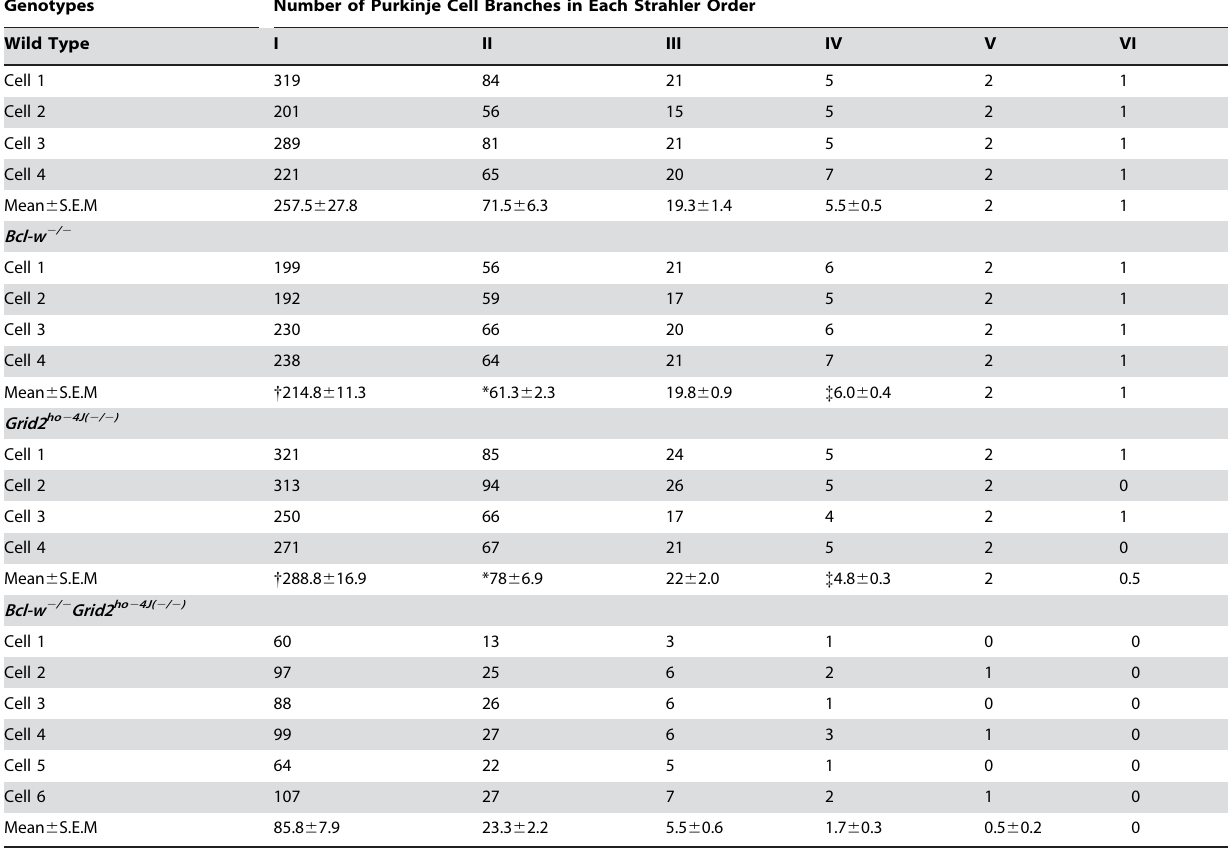
Purkinje cell dendritic abnormalities in Bcl-w 2 / 2 Grid2 ho 2 4J( 2 / 2 ) mice were quantified using the Strahler system of topological analysis on Golgi-stained Purkinje cells. The number of the dendritic branches in each Strahler order was counted for several Purkinje cells for wild type, single knockout, and double knockout mice. Statistic analysis was performed between two genotypes of mice in each order using student t-test. Purkinje cells in Bcl-w 2 / 2 Grid2 ho 2 4J( 2 / 2 ) mice are significantly different from all other genotypes in every Strahler order (p , 0.01). { , * , { Indicate the significant difference (p , 0.05) in the first, the second, and the fourth Strahler order between Bcl- w 2 / 2 and Grid2 ho 2 4J( 2 / 2 )